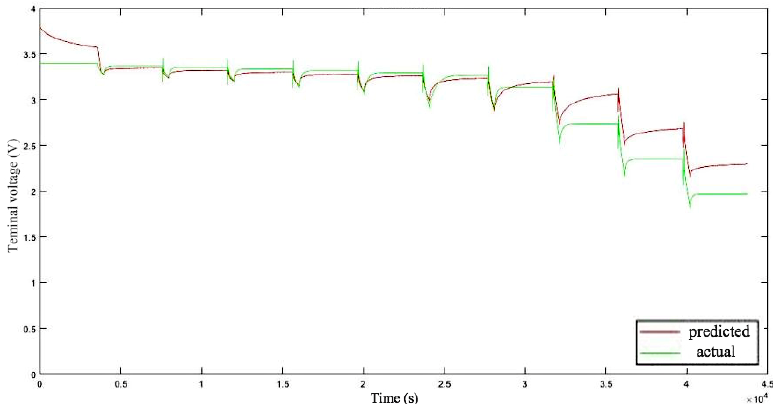
Figure 9. Comparison chart of predicted terminal voltage and actual value.